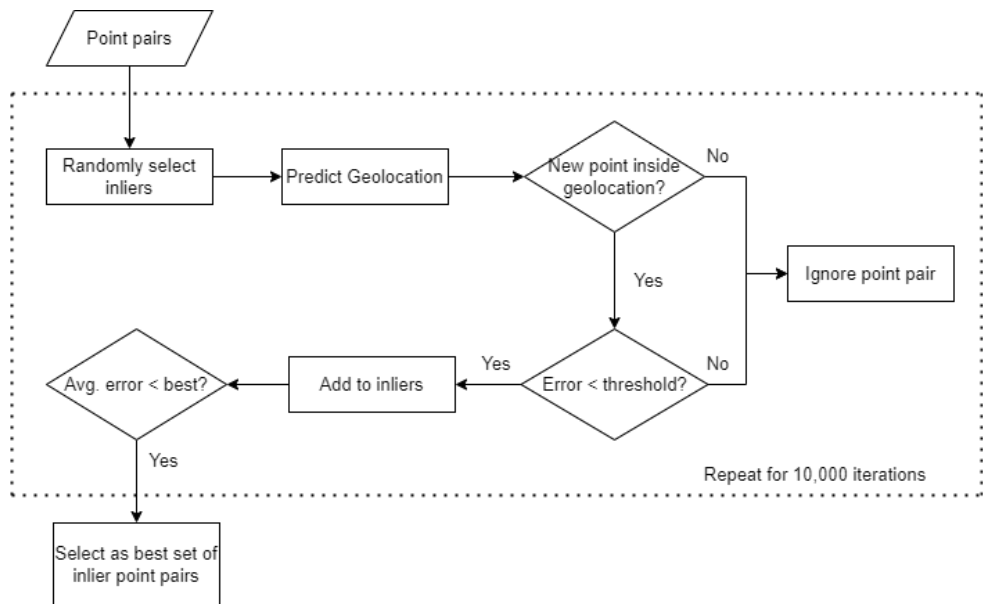
Figure 8. Overview of the RANSAC outlier filtering